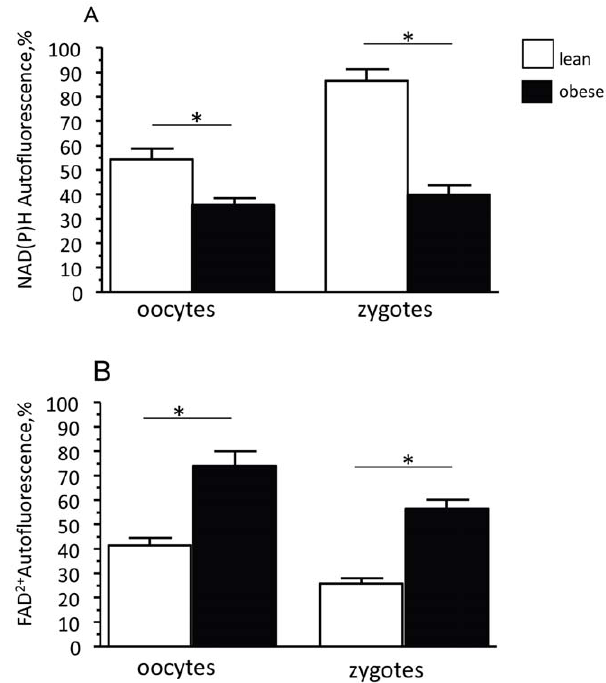
Figure 2. Maternal diet-induced obesity is associated with an oxidised intracellular redox state in oocytes and zygotes. The redox state of single oocytes and zygotes from lean (n=15 cells/group) and obese (n=15 cells/group) mice was estimated through measure- ments of NAD(P)H and FAD 2 + autofluorescence intensity. The resting redox state is defined as a ratio of the maximally oxidised (response to 1 mM FCCP) and maximally reduced (response to 1 mM NaCN) signals. The fluorescence signals are normalised between 100 and 0. For NAD(P)H autofluorescence (A): 0 - maximally oxidised state; 100 – maximally reduced state. This scale is reversed for FAD 2 + fluorescence (B). 0 – maximally reduced state; 100 – maximally oxidised state. * p , 0.05 relative lean group. Data are mean 6